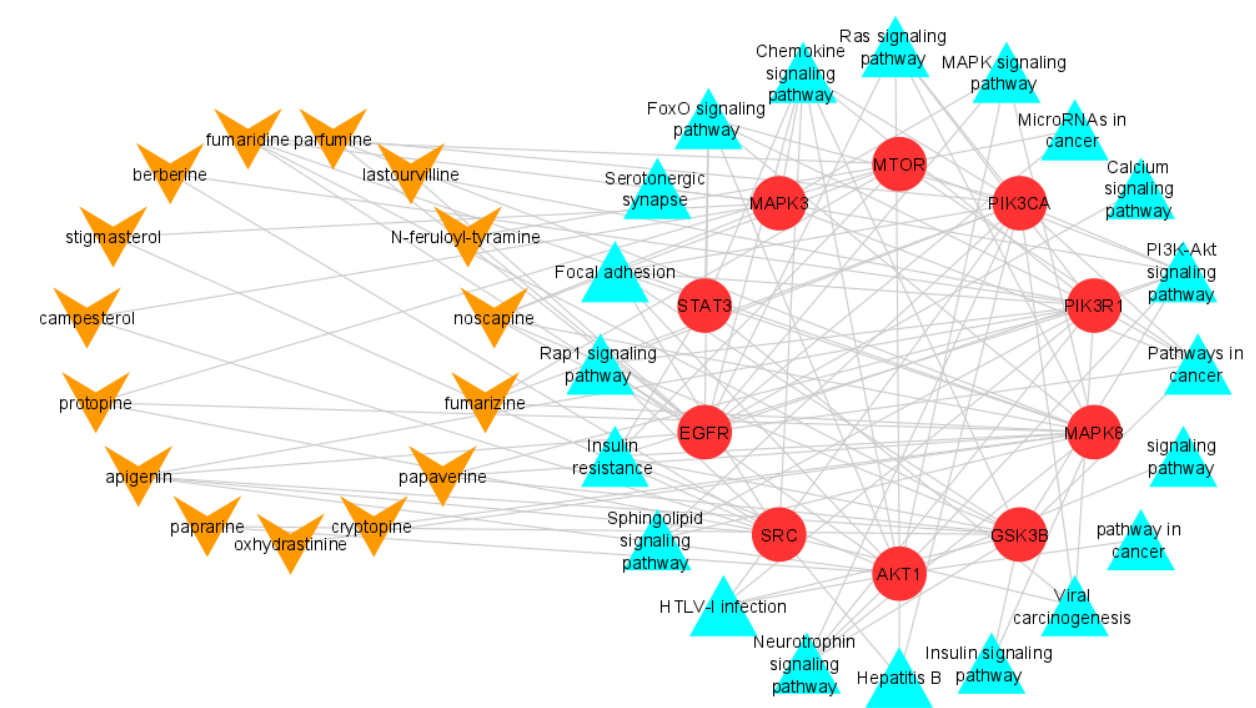
Figure 3. Pathways influenced by F. indica . The red nodes represent the hub genes, the orange nodes represent active compounds, and the blue nodes are the pathways associated with the core targets.